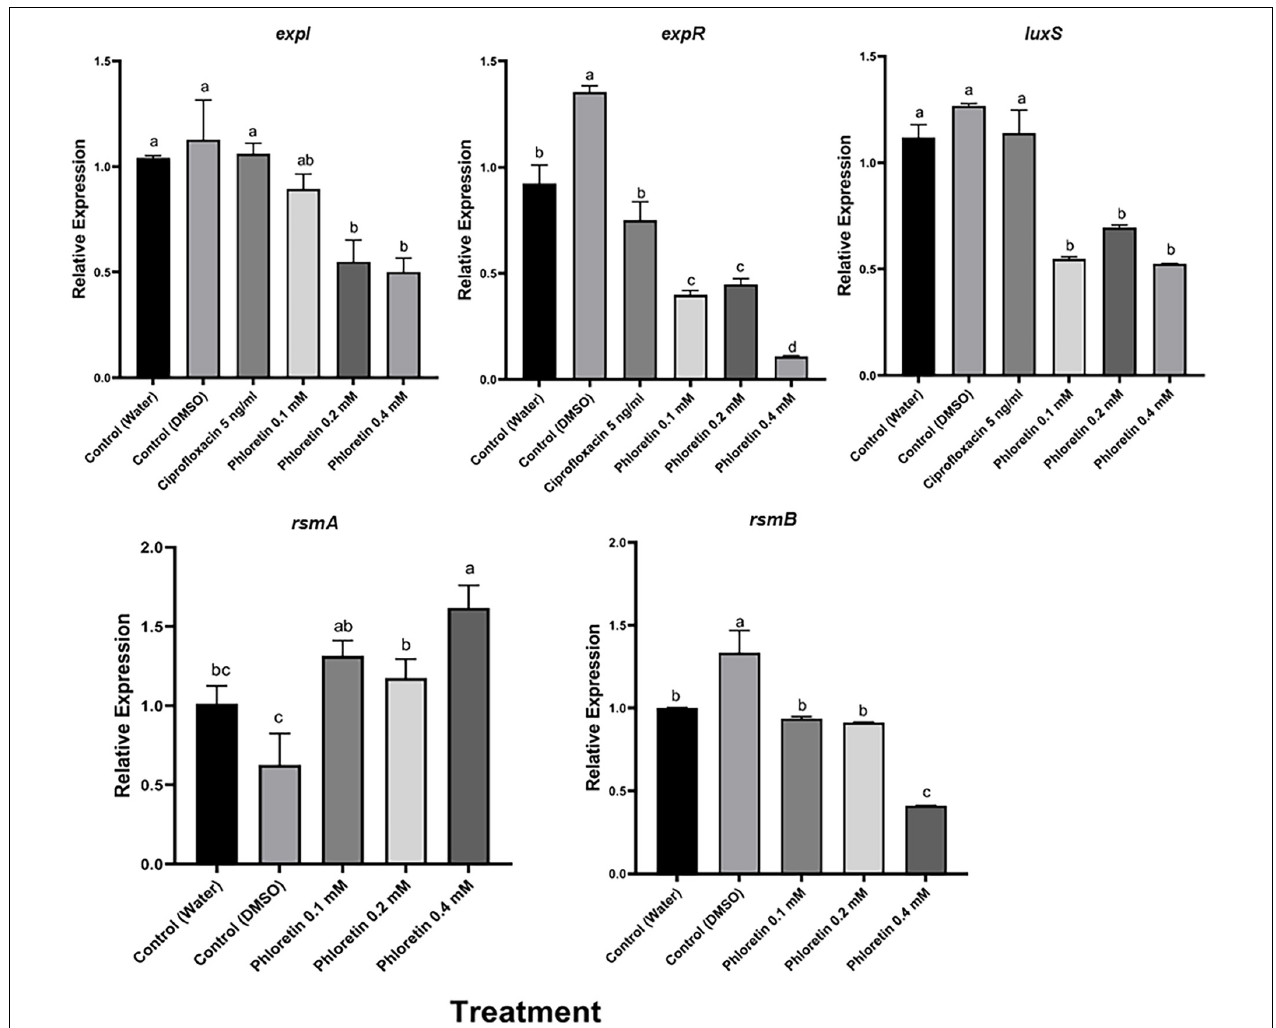
FIGURE 6 | Effects of phloretin on transcript level of genes associated with quorum-sensing (QS) in Pectobacterium brasiliense Pb1692. The expression levels of the genes expI , expR , QS gene luxS (AI-2 system), rsmA and rsmB were determined by qPCR of cDNA samples prepared from RNA extracts of bacterial cultures grown in LB (28 ◦ C, 8 h), in the presence of phloretin (0.1, 0.2, and 0.4 mM), ciprofloxacin 5 ng/ml, dH 2 0 or 0.3% DMSO. Bars represent the relative gene expression observed in one experiment, means + standard errors (SE) of 6 replicates per treatment. The experiments were repeated twice. Bars that are not labeled with the same letter are significantly different from each other ( P < 0.05; bar = mean + SE; n =